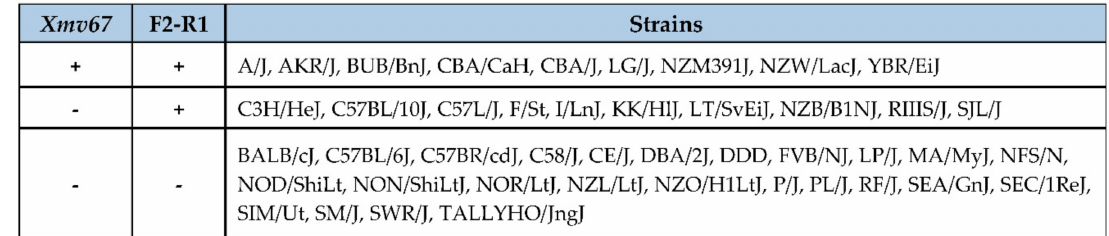
Figure 3. Distribution of Xmv67 and F2–R1 in common inbred mouse